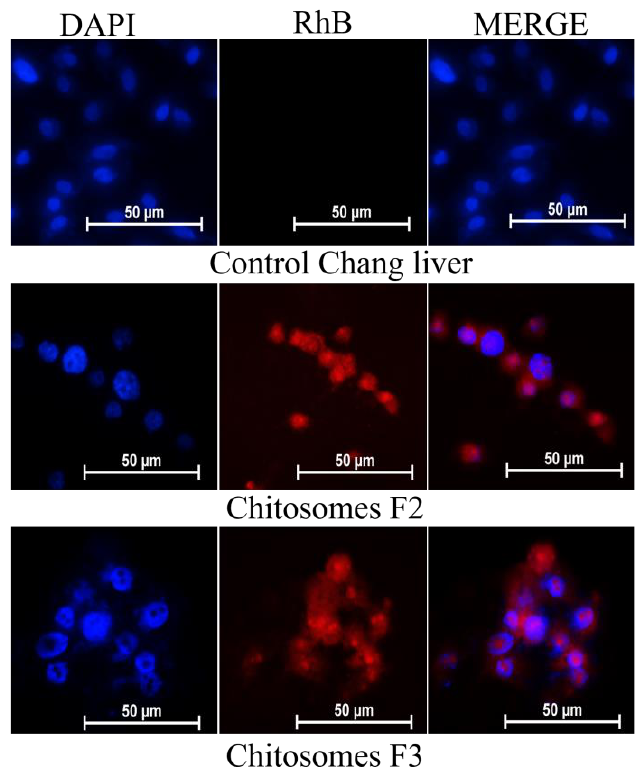
Figure 8. In vitro cellular uptake study of RhB-loaded chitosomes; (F2 and F3); M-HeLa cell line. Blue channel: DAPI fluorescence (nuclei); red channel: RhB fluorescence (chitosomes).